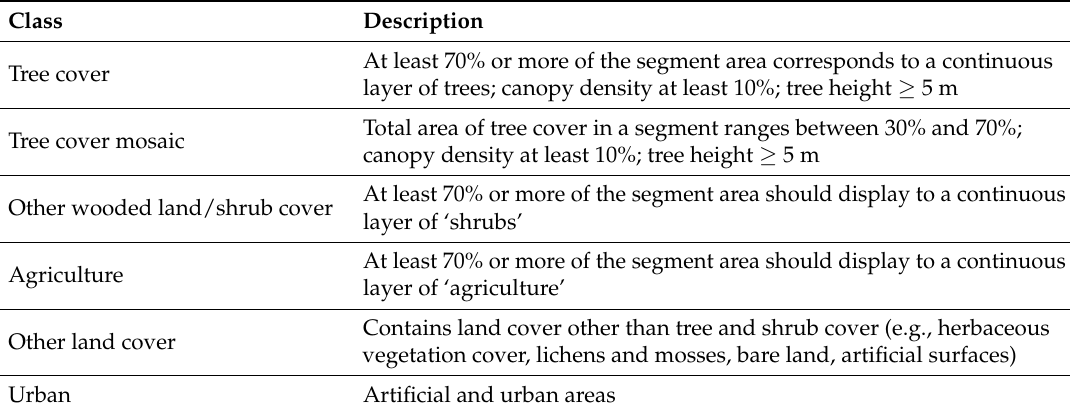
Table 1. Land cover classification definition